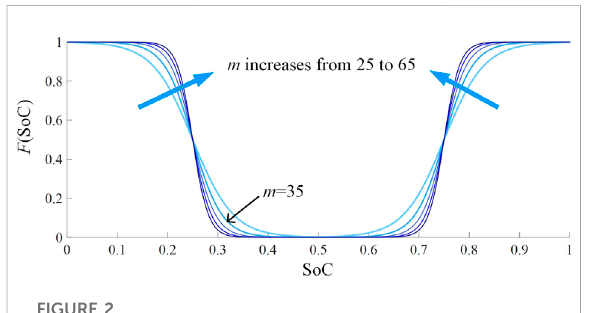
FIGURE 2 Different curves of F (SoC) when the value of the adaptive factor m increases from 25 to 65.